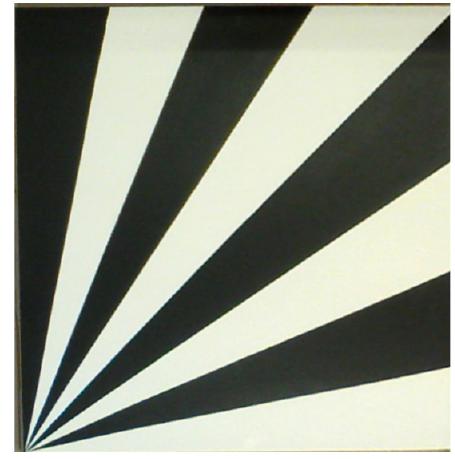
Figure 2. Segment no 1: the quarter of Siemens star (image obtained with RGB camera)